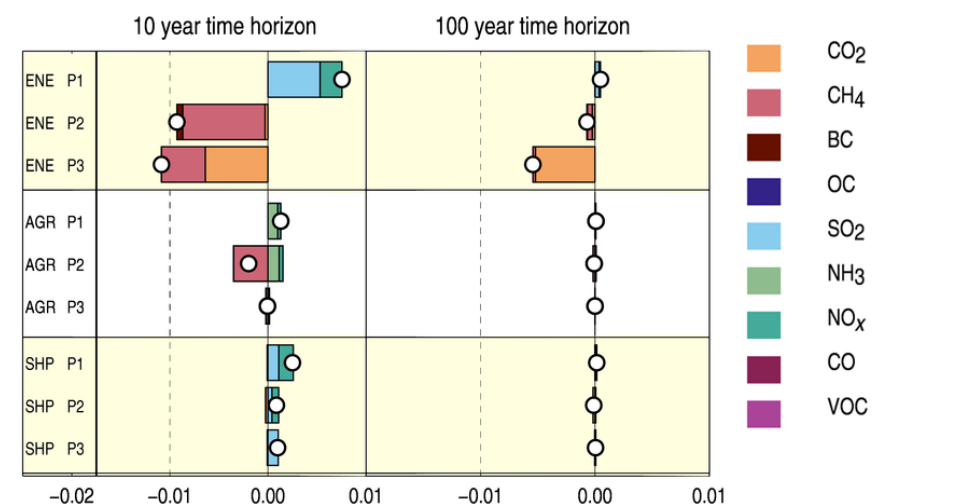
Figure 3. Global-mean surface temperature impact ( ◦ C) on 10- and 100-year time horizons resulting from instantaneous reductions of different sets (listed in Table 2) of SLCFs and CO 2 emissions. White circles indicate the net impact of these